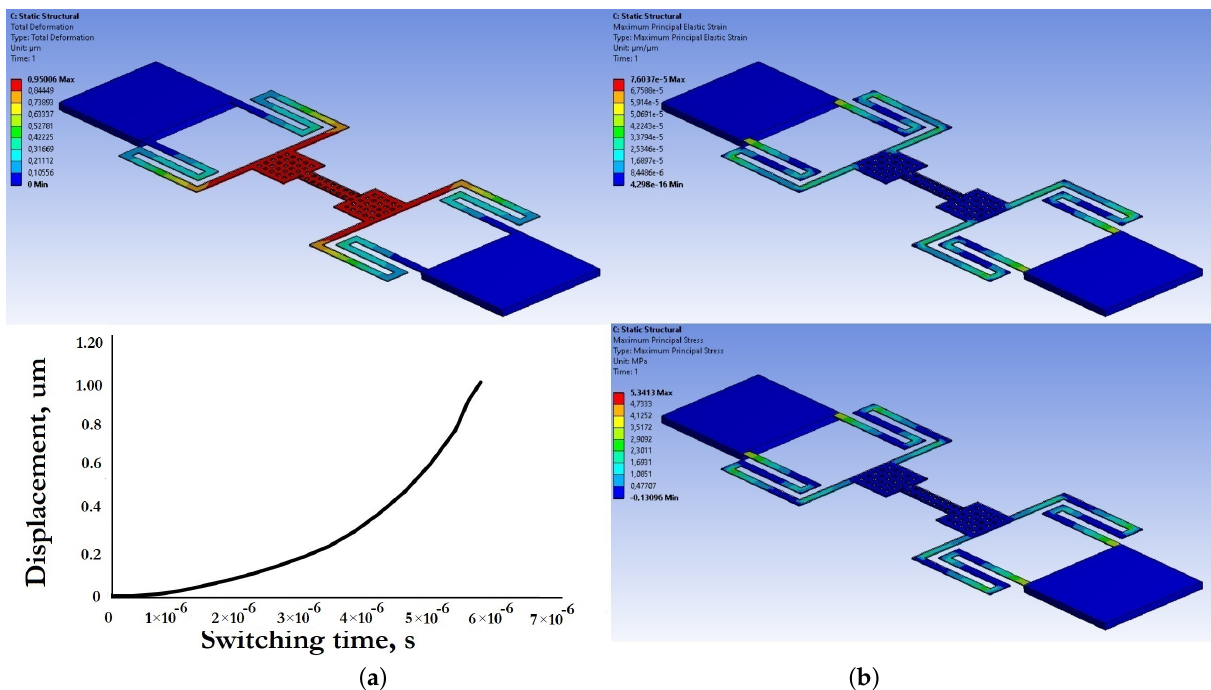
Figure 18. The results of modeling of electromechanical parameters of switch (B): ( a ) electrostatic displacement and switching time; ( b ) distribution of mechanical strain and mechanical stress.